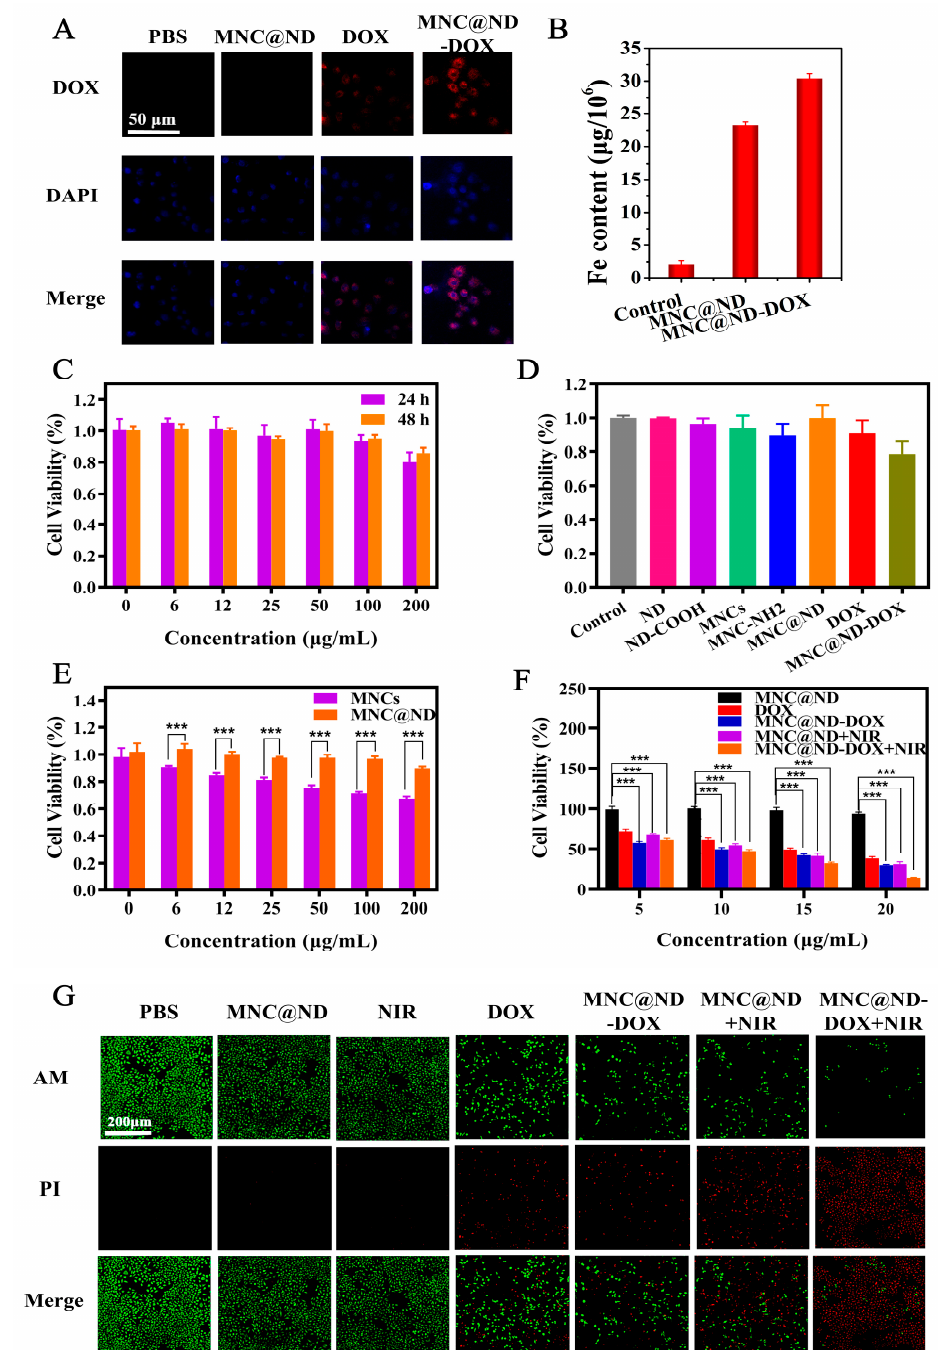
Figure 3. ( A ) Confocal fluorescence images of A549 cells incubated with PBS, MNC@ND NPs, DOX and MNC@ND-DOX NPs for 4 h. ( B ) The amount of Fe element in A549 cell. ( C ) Cell viability of A549 cells treated with different concentration of MNC@ND NPs after 24 and 48 h. ( D ) Cell viability of A549 cells treated with different materials. ( E ) Cell viability of A549 cells treated with different concentration of MNCs and MNCs@ND, A549 cells treated with 0 concentration were used as control. ( F ) Cell viability of A549 cells treated with MNC@ND NPs, DOX, MNC@ND-DOX NPs, MNC@ND NPs + NIR and MNC@ND-DOX NPs+NIR at different concentrations of DOX and the corresponding amount of drug-free nanocapsules. Data are mean ± SD ( n = 3, *** p < 0.001). ( G ) Fluorescence images of calcein AM/PI-stained A549 cells incubated with PBS, MNC@ND, NIR, DOX, MNC@ND-DOX NPs, MNC@ND+NIR and MNC@ND-DOX+NIR NPs.